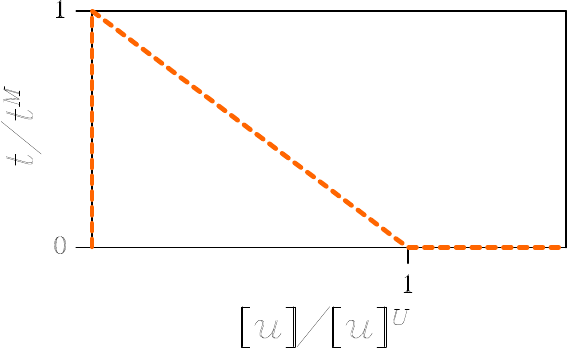
Figure 4. Adopted effective traction t – displacement discontinuity [ u ] cohesive